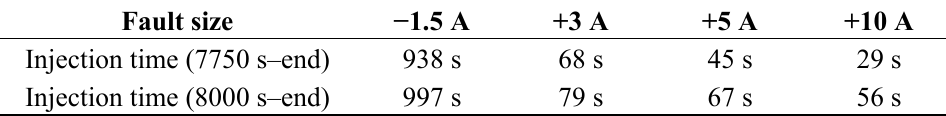
Figure 10. Current sensor fault diagnostic results under UDC test. ( a ) Generated residual r ; ( b ) Filtered residual r ; ( c ) Residual evaluation result S ( k ) using CUSUM; ( d ) Detected current sensor fault. Table 1. Detection times for current sensor faults under UDC tests.